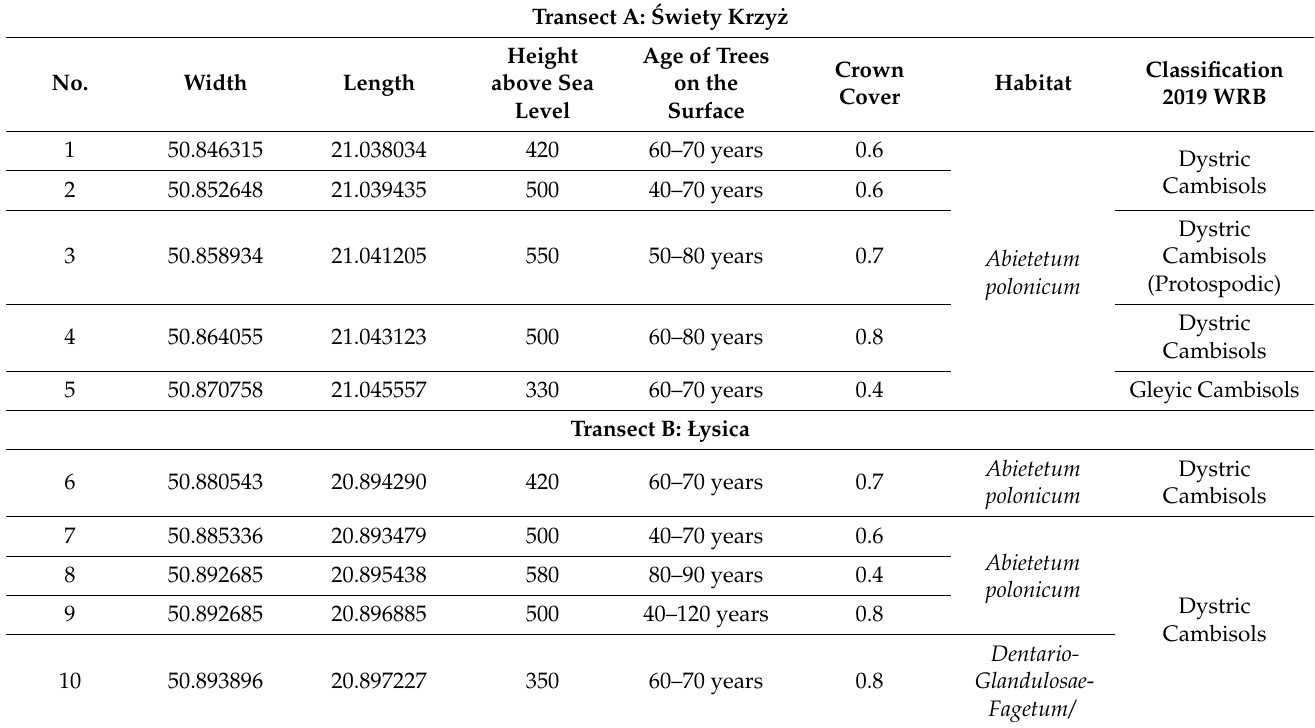
Table 1. Characteristics of research